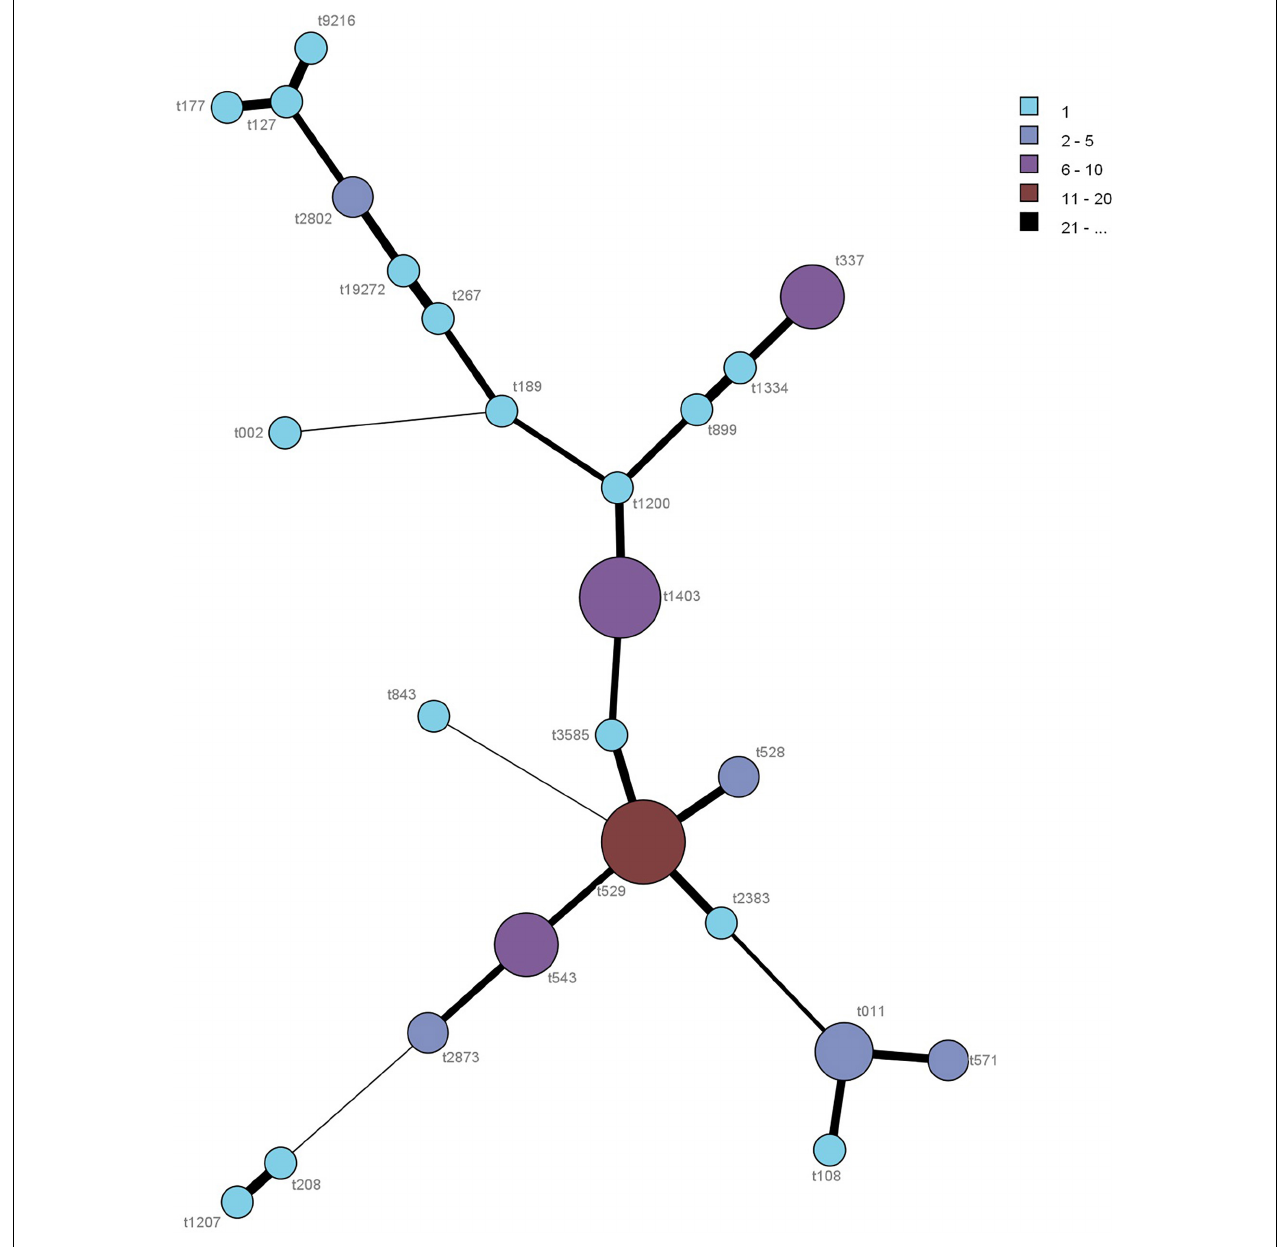
FIGURE 2 | Minimum spanning tree of the spa typing for the 62 S. aureus isolates. Each spa type is depicted by a single node, with the size of the node representing the number of isolates associated with this spa